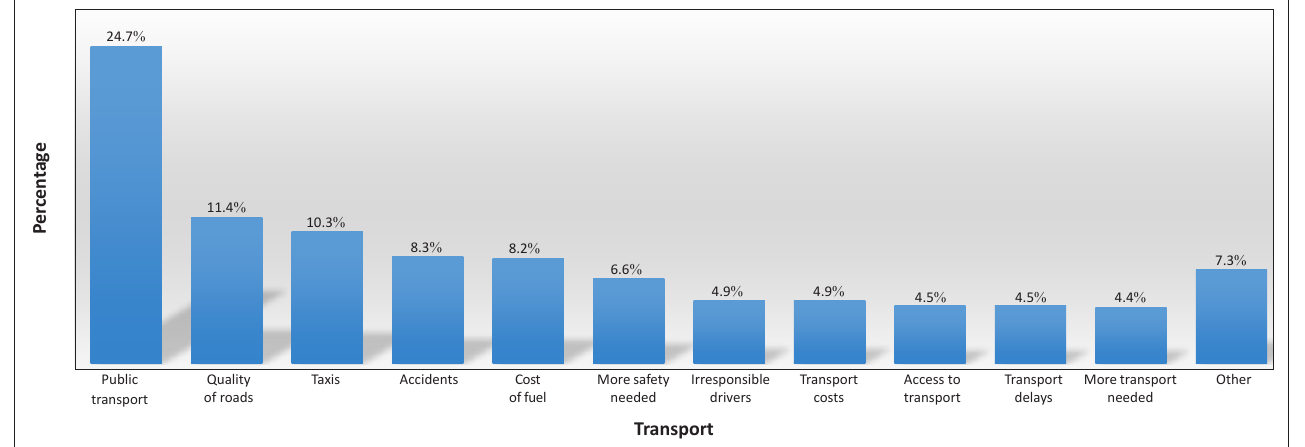
FIGURE 6: Highest transport